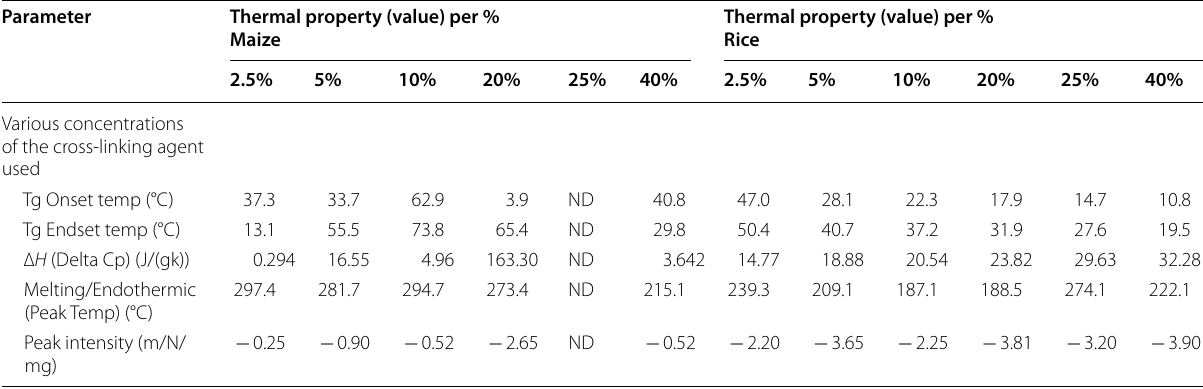
KEY: Tg Glass Transition; ∆H =